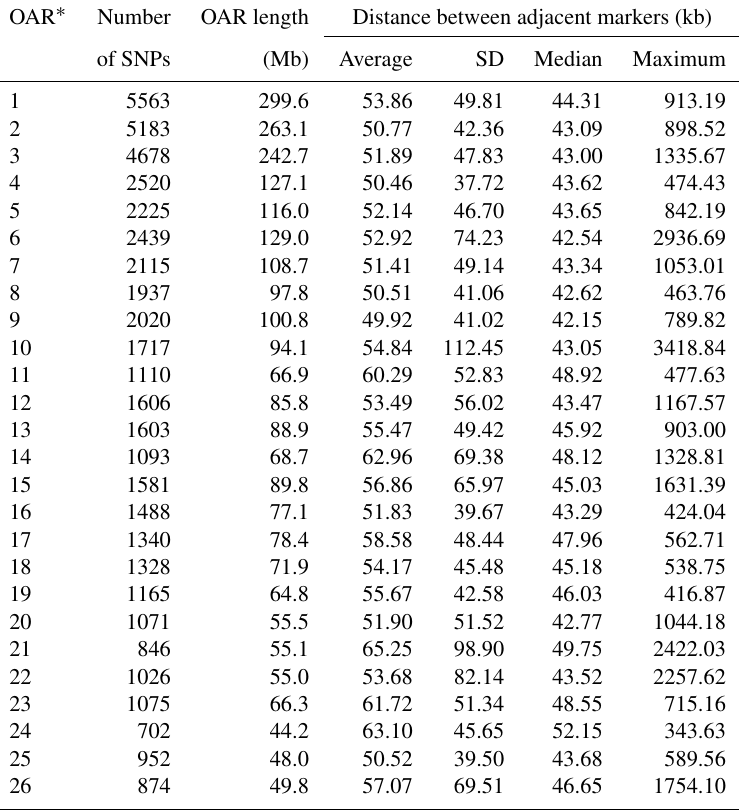
Table 1. Summary statistics of single-nucleotide polymorphism (SNP) markers for each Ovine autosome.